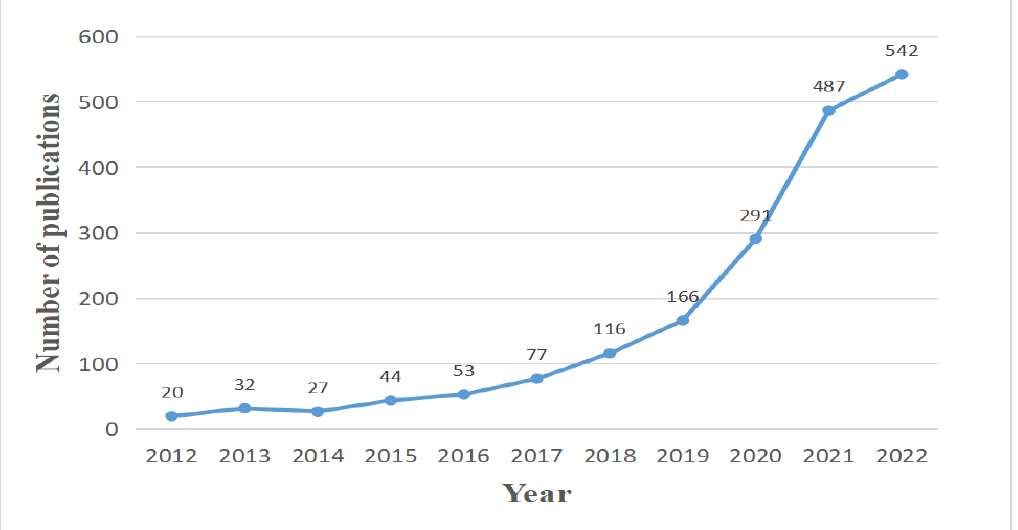
Figure 2. Al-related publications on food safety from 2012 to 2022.